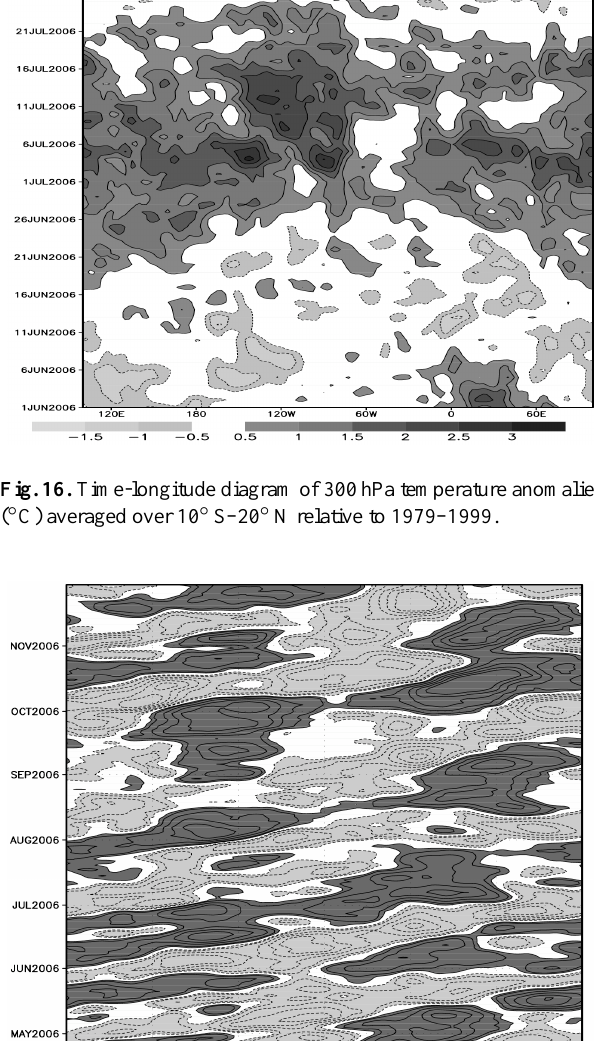
Figure 17. Time-longitude diagram of 200 hPa velocity potential anomalies averaged on 5°S- 15°N relative to 1979-1999. Positive (negative) values are in black (grey) with isolines 1, 2, 4, 6, 8 and 10 10 6 m 2 .s -2 .